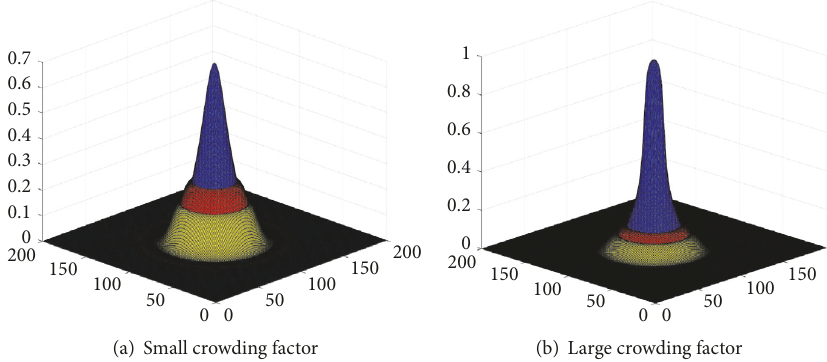
Figure 17: Impact of crowding factor ( 𝛼 = 0.1 vs 𝛼 = 0.9 ) on the growth of tumor cells,